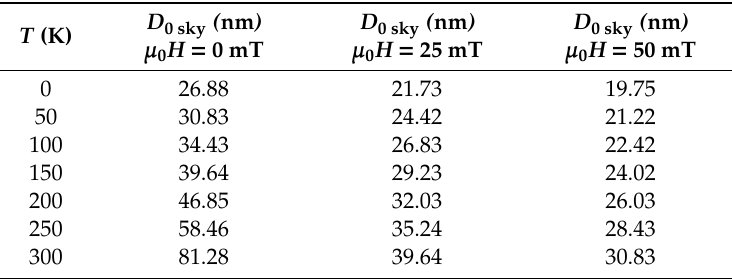
Table 2. Calculated D 0 sky used in the numerical calculations 39 .